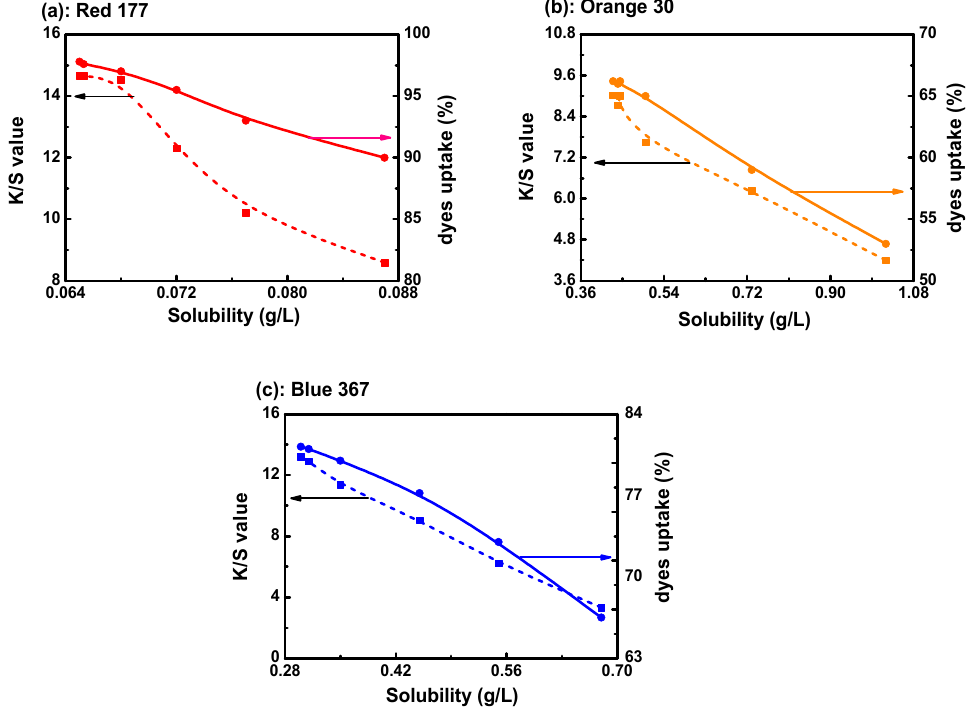
Figure 5. The relationship between dye solubility and K/S value and dye uptake: ( a ) C. I. Disperse Red 177, ( b ) C. I. Disperse Orange 30, and ( c ) C. I. Disperse Blue 367.